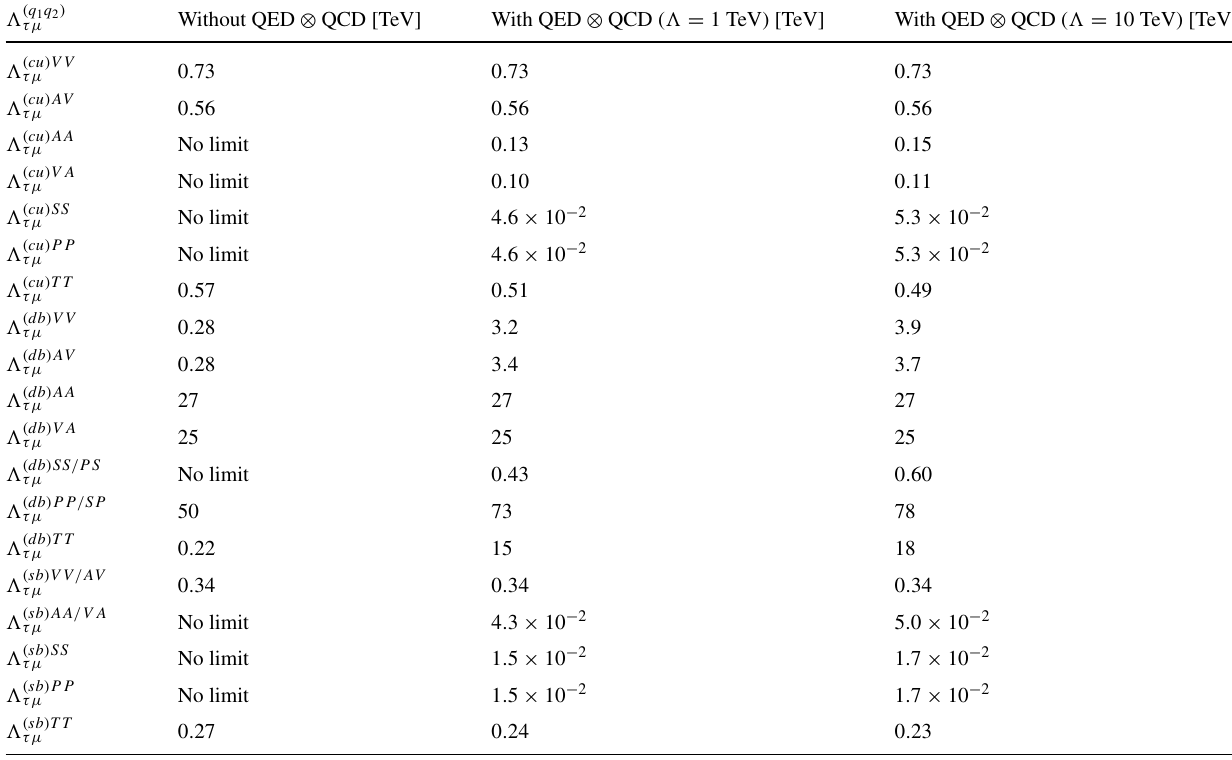
( q 1 q 2 ) AB (cid:2) 1 (cid:2)